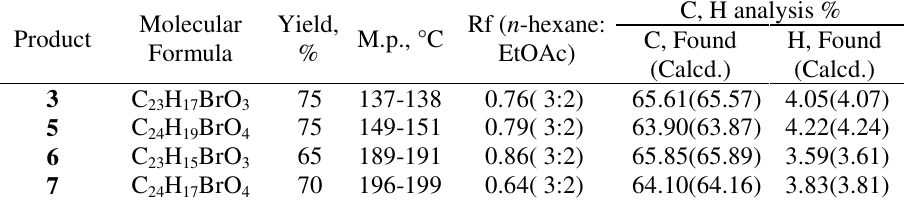
Table 1. Characteristic data of the synthesized